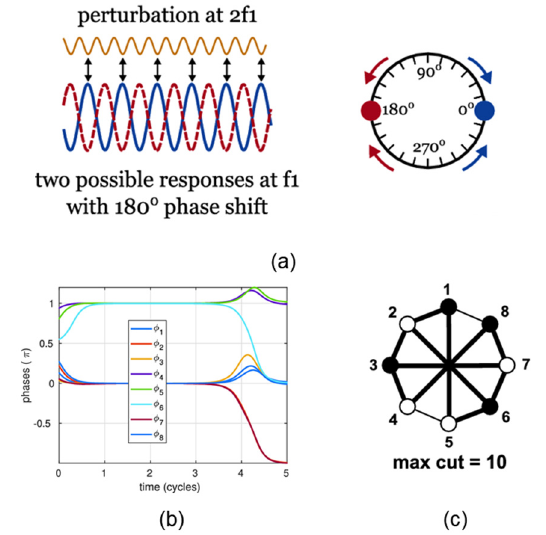
Figure 6. ( a ) Schematic diagram of second-harmonic injection locking (SHIL); ( b ) binarization of phases; ( c ) one of the optimal solutions to the 8-vertex max-cut problem [18].